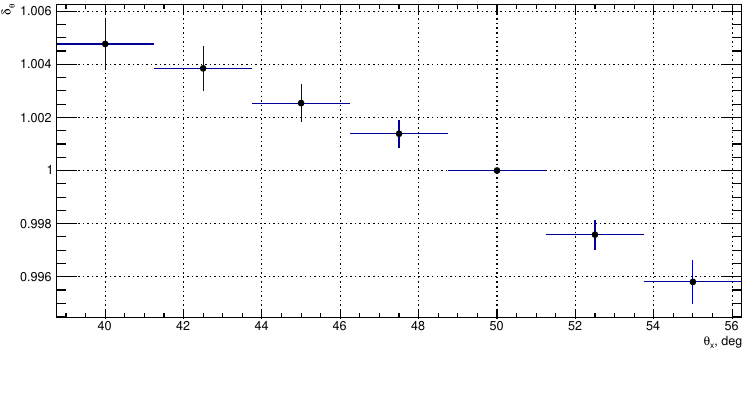
Figure 9 . The (cid:14) (cid:18) dependence on (cid:18) x (3.10).